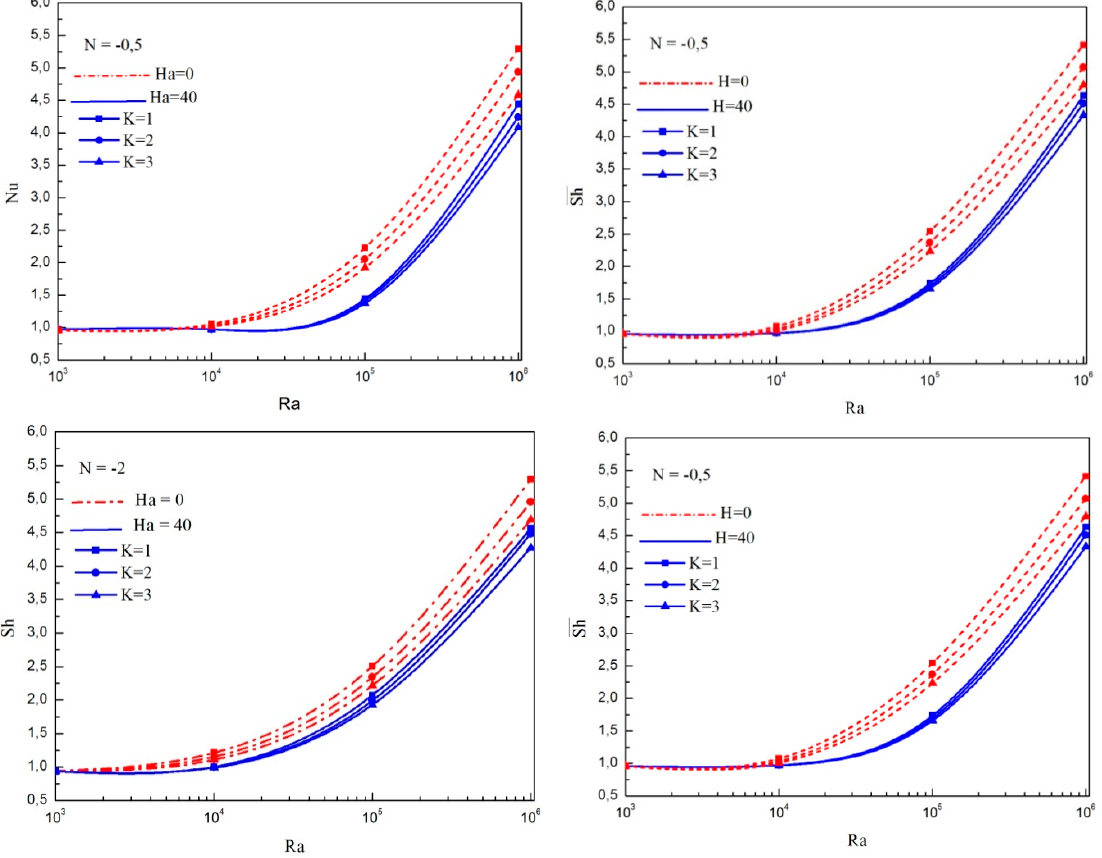
Figure 18. Effect of Rayleigh number Ra and vortex viscosity parameter K on Nu and Sh without (Ha = 0) and with (Ha = 40) magnetic field for, N = − 0.5 (Top) and N = − 2 (Bottom).